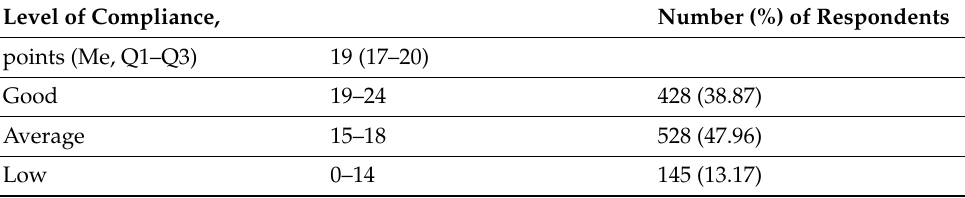
Table 3. Level of compliance with restrictions during the COVID-19